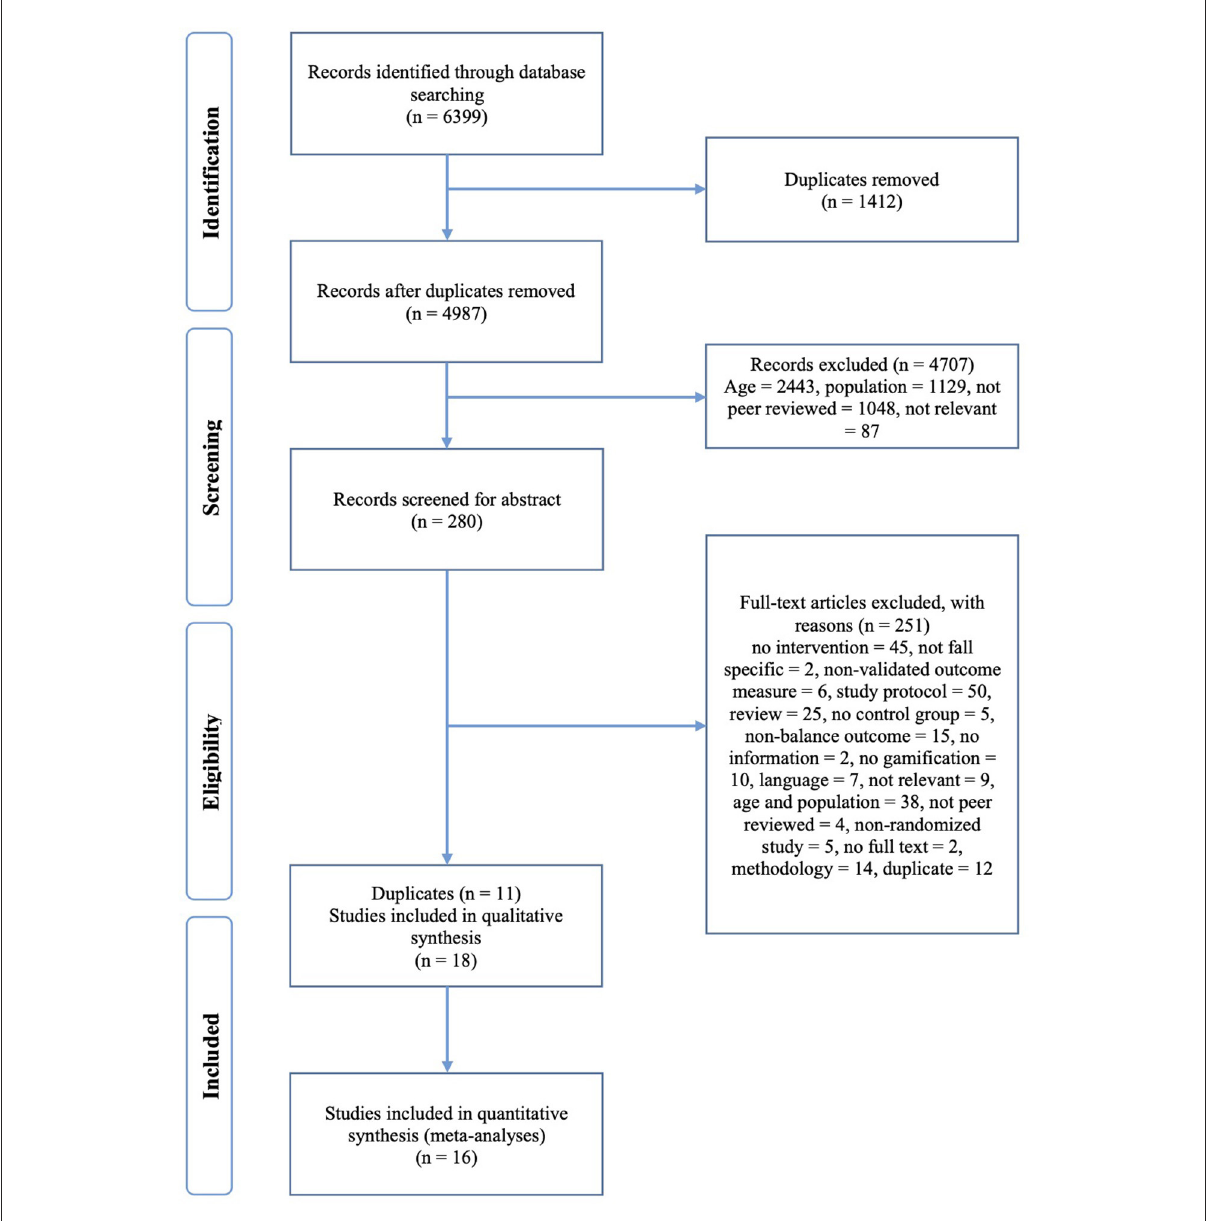
FIGURE1 PRISMA flowchart of the article selection